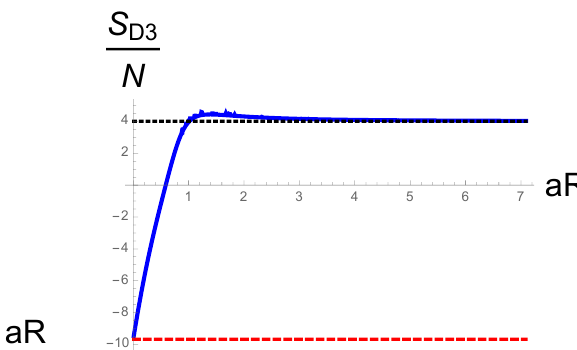
N ~ (cid:20) indicated by the dashed black line. 3